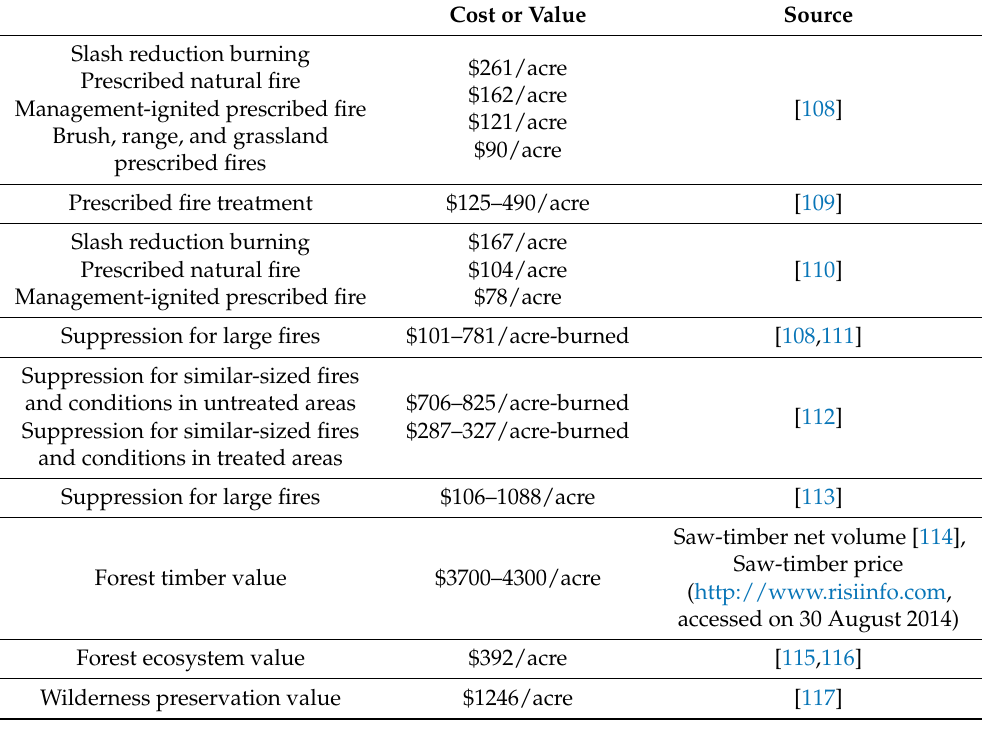
Table 1. Estimation of prescribed burning cost, suppression cost, and forest value to be